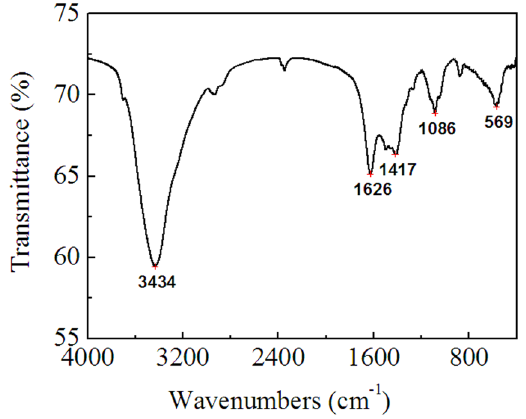
Figure 13. FTIR spectra of BP.